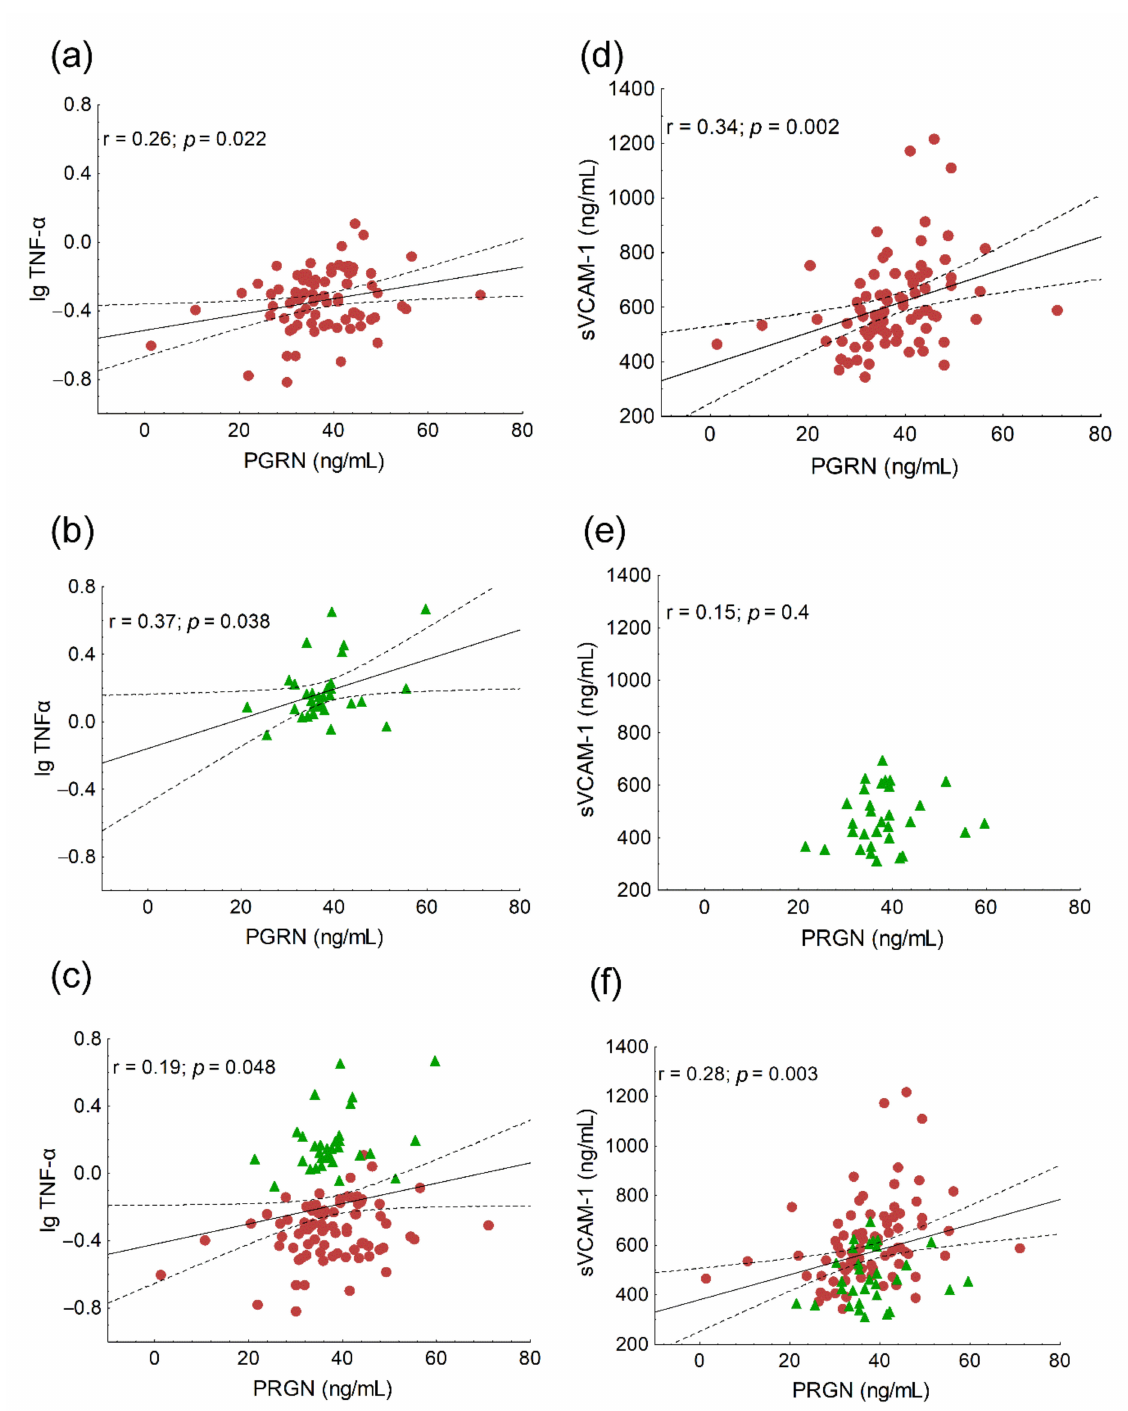
Figure 3. The correlations between the serum of tumor necrosis factor-alpha (TNF α ) and progranulin (PGRN) in heterozygous familial hypercholesterolemic (HeFH) patients ( a ), healthy controls ( b ) and the whole study population ( c ). The correlations between the serum vascular intercellular adhesion molecule-1 (sVCAM-1) and progranulin (PGRN) in heterozygous familial hypercholesterolemic (HeFH) patients ( d ), healthy controls ( e ) and the whole study population ( f